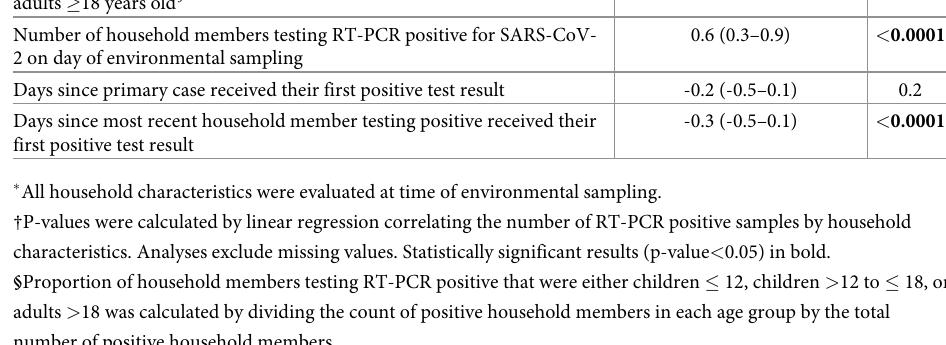
p-value Interval)